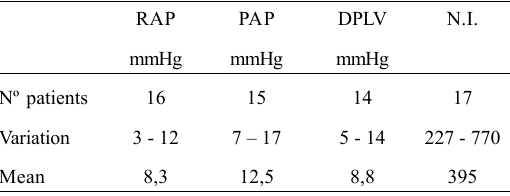
Table 1. Pre-operative data - 18 patients